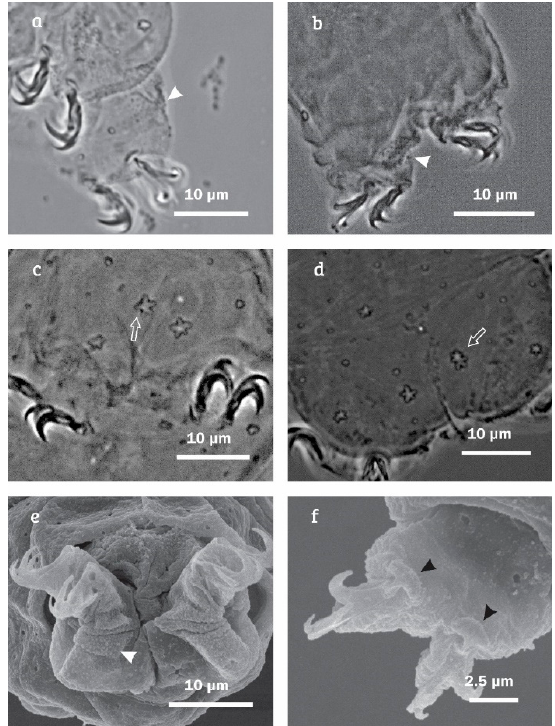
Figure 7. Minibiotus citlalium sp. nov. detail of legs IV: ( a ) granulation (paratype 14, PCM); ( b ) granulation (paratype 5, PCM); ( c ) star-shaped pores (paratype 13, PCM; ( d ) star-shaped pores (holotype, PCM, empty arrow indicate the pair of star-shaped pores); ( e ) granulation on dorsal surface (SEM, white arrowheads indicate granulation); and ( f ) claw IV with smooth lunules (SEM, black arrowheads).